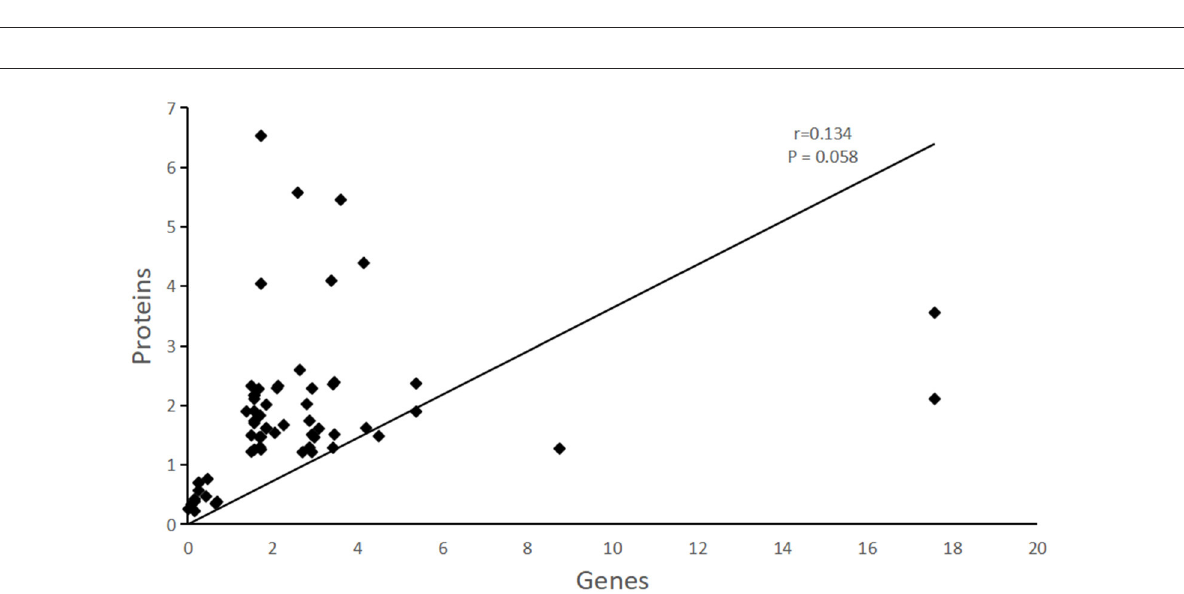
FIGURE3 The correlation between the gene and protein expression